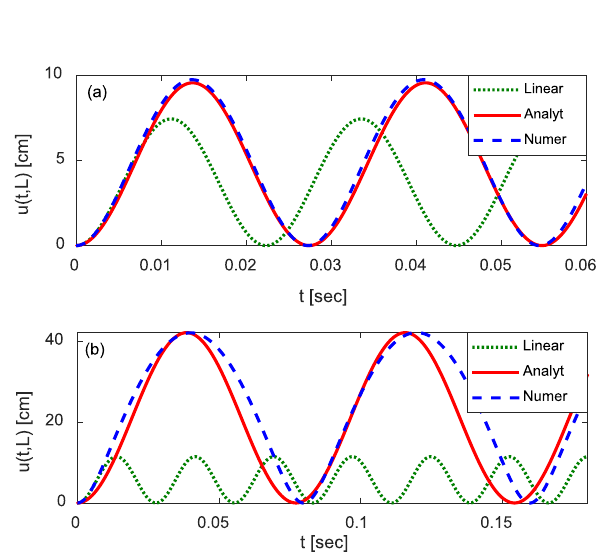
Figure 4. Numerical and approximate analytical solutions for the horizontal displacement of the tip of the cantilever wall u ( t , L ) vs. time t with ( a ) L = 2.54 m and ( b ) L = 5 m, d = 4.572 m, E = 20,700